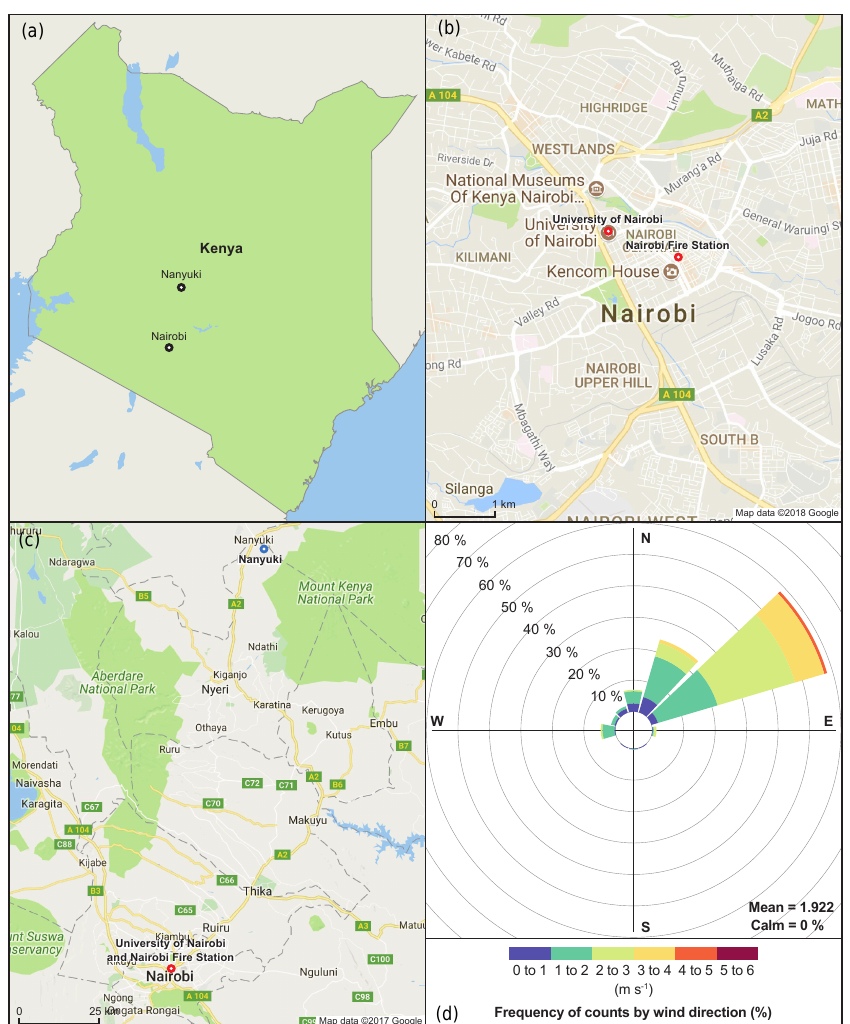
Figure 1. Locations of data collection sites and wind rose for the urban background location. (a, c) Locations of Nairobi and Nanyuki in Kenya. Panel (b) shows relative locations of urban background locations (University of Nairobi, American Wing) and urban roadside location (Nairobi fire station). (d) Wind rose generated from data collected at the urban background location during the measurement campaign.